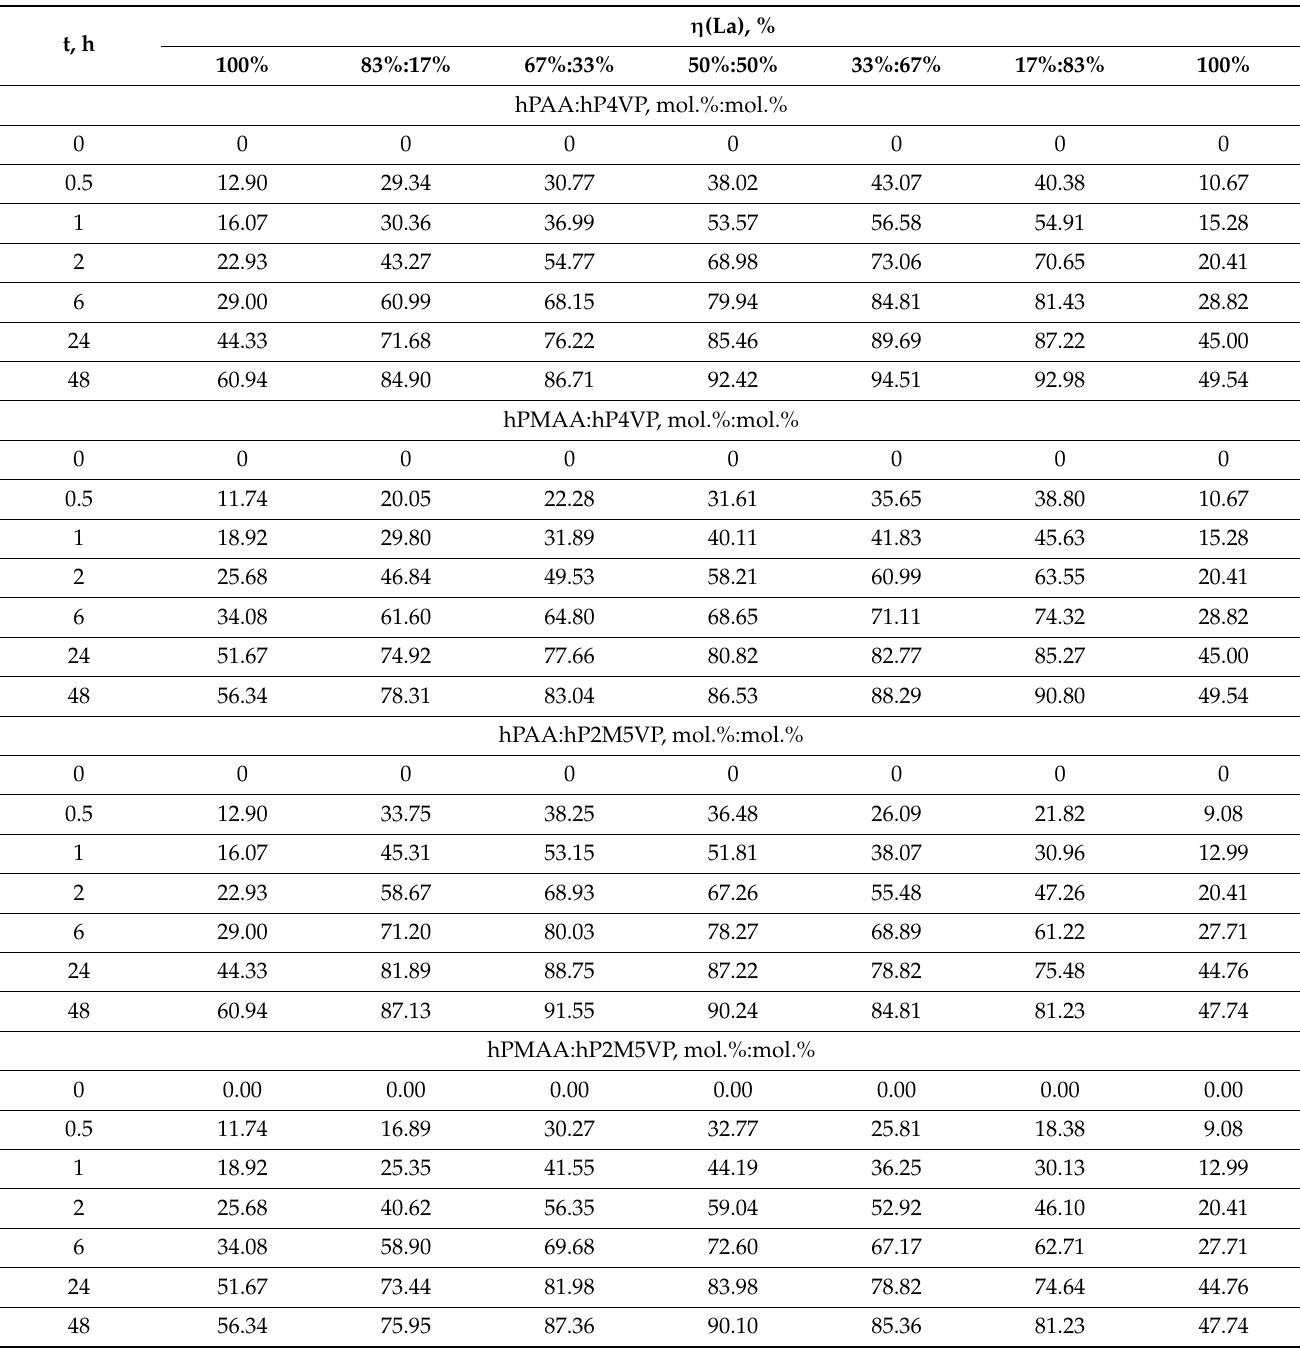
Table 1. Lanthanum sorption degree of the interpolymer